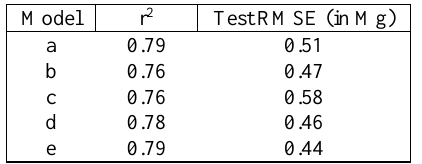
Table 5. Summary of accuracies and error for each model